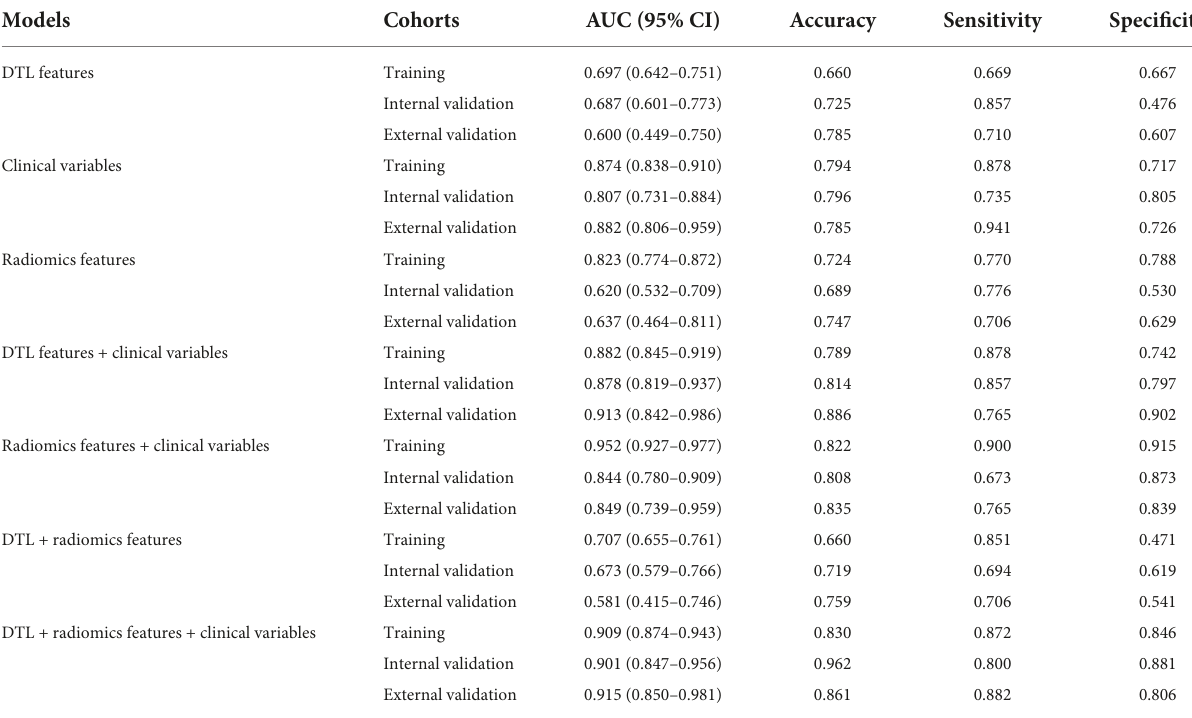
TABLE 3 Performance of various combined